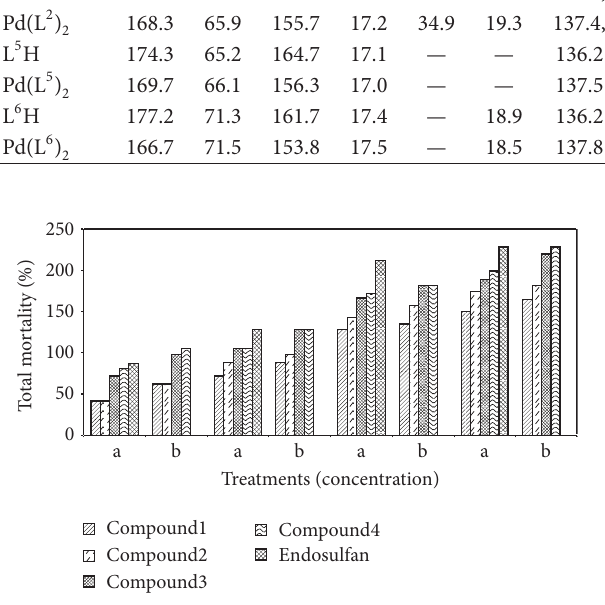
F 1: Total percentage of mortality of third instar H. armigera pest aer 1, 3, 7, and 10